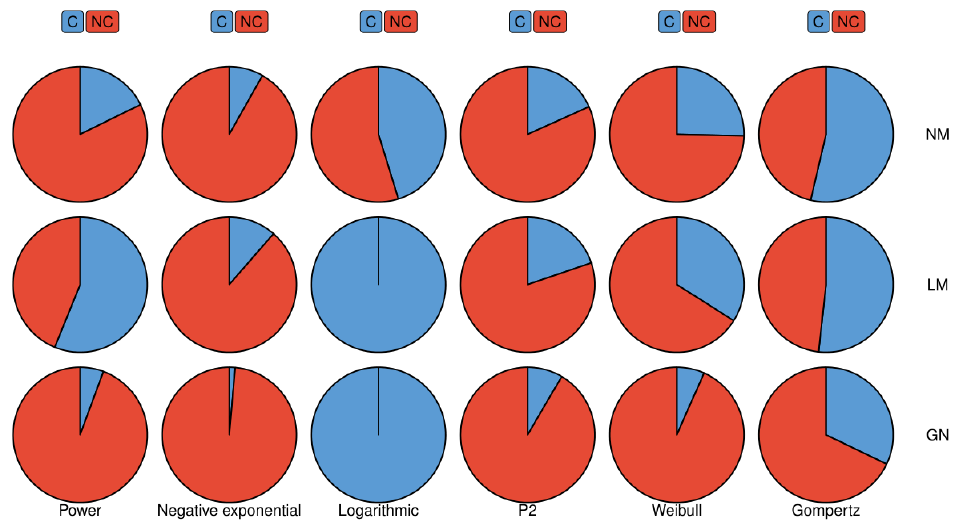
method, and NM represents the Nelder–Mead method. and NM represents the Nelder–Mead method. 𝑥𝑥 𝑇𝑇 𝑥𝑥 0